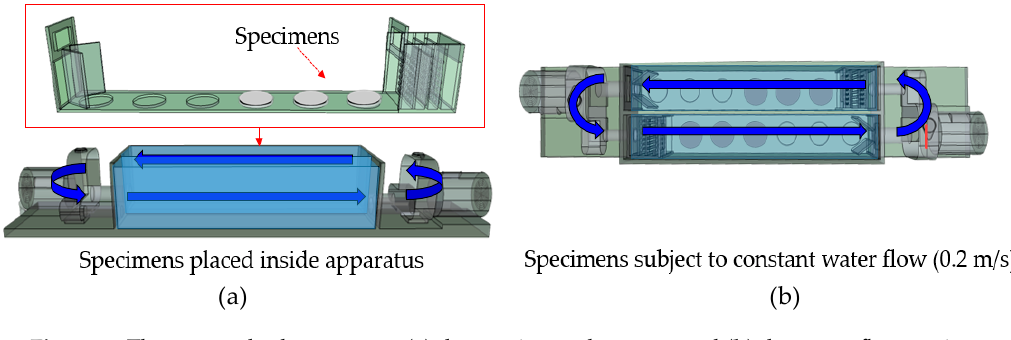
Figure 9. The test method apparatus: ( a ) the specimen placement and ( b ) the water flow testing.